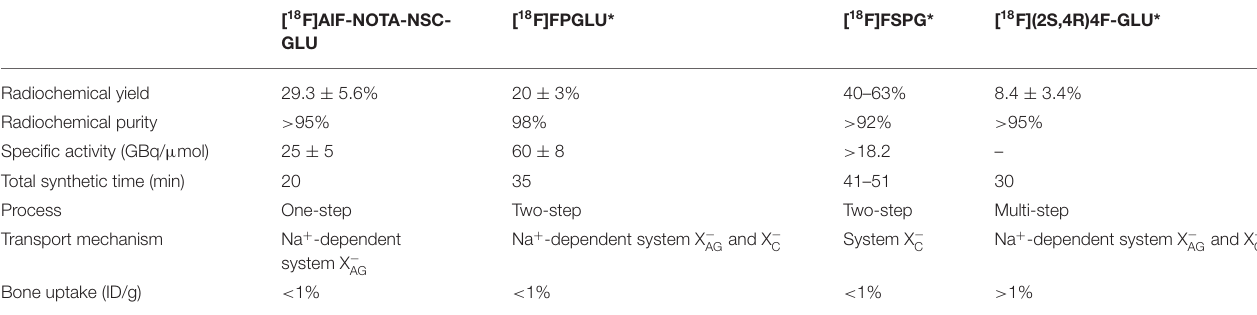
TABLE 3 | The comparisons of [ 18 F]AlF-NOTA-NSC-GLU, [ 18 F]FPGLU * , [ 18 F]FSPG * , and [ 18 F](2S,4R)4F-GLU *